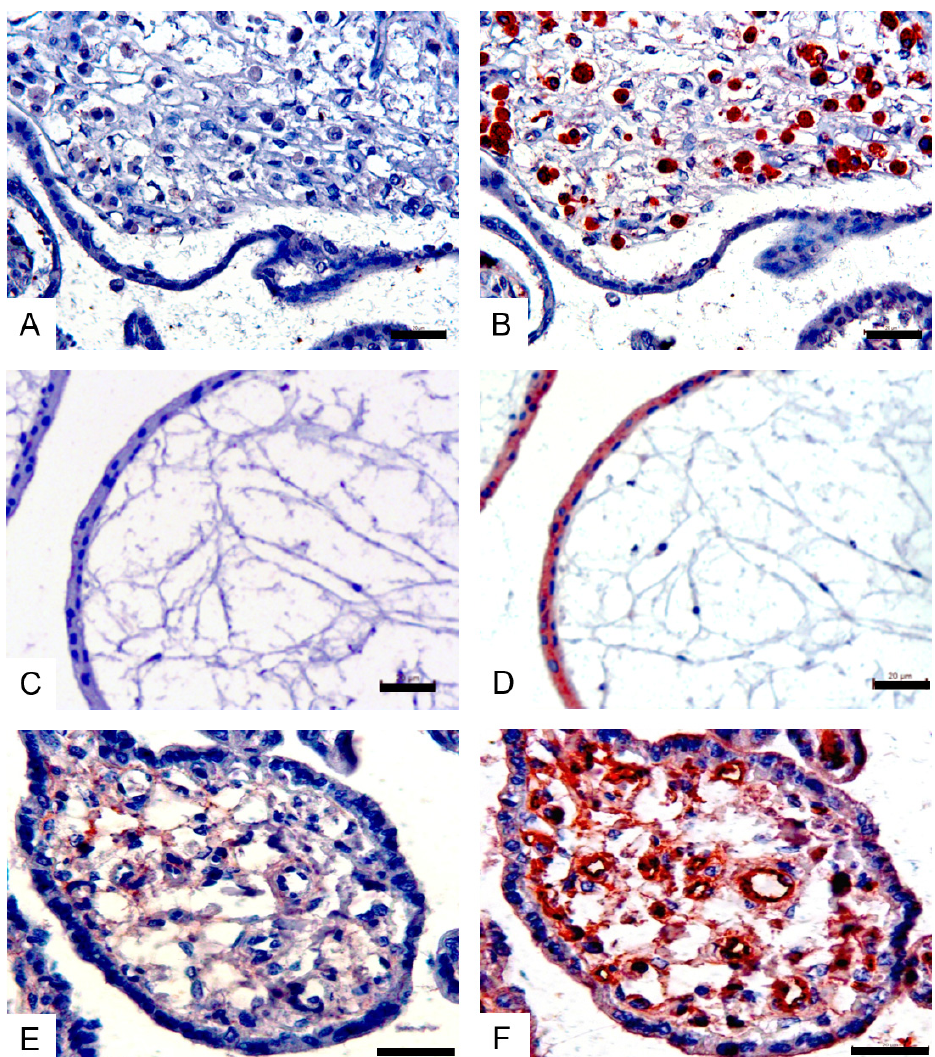
Figure 2. NA pretreatment lectin staining of human placenta tissue. Serial sections of the placenta tissue were stained with SNA ( A , B ), MAA I ( C , D ) and MAA II ( E , F ), after being treated with ( A , C , E ) or without ( B , D , F ) neuraminidase. All sections were counterstained with hematoxylin. Scale bar = 20 μ m.